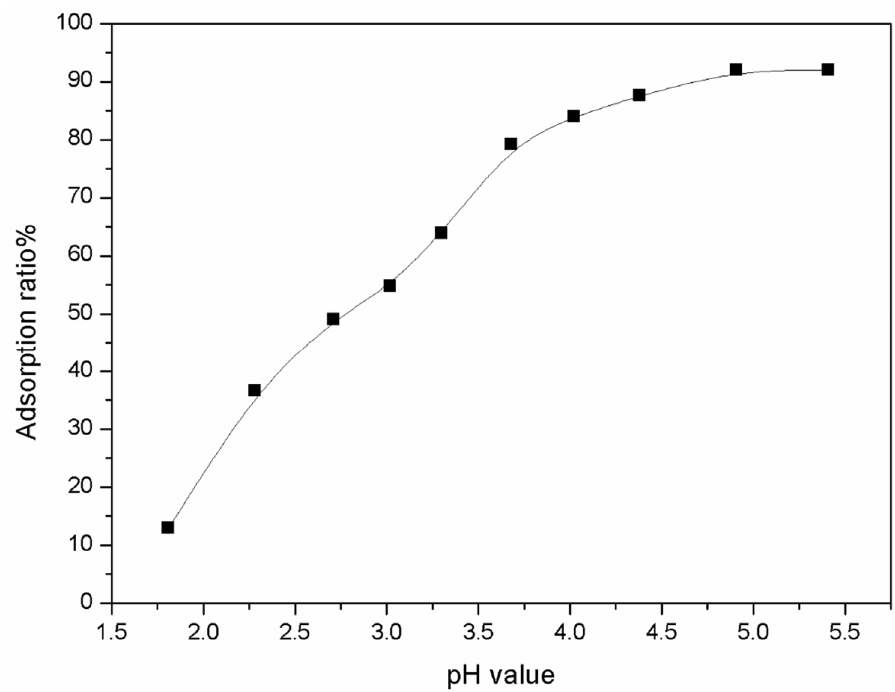
Figure 7. Effect of pH value. (Experiment conditions: C 0 [Th(IV)] = 19.00 ± 0.10 mg/L; solid/liquid ratio = 0.032 g/L; T = 298.15 ± 1.00 K; t = 0.5 h.)